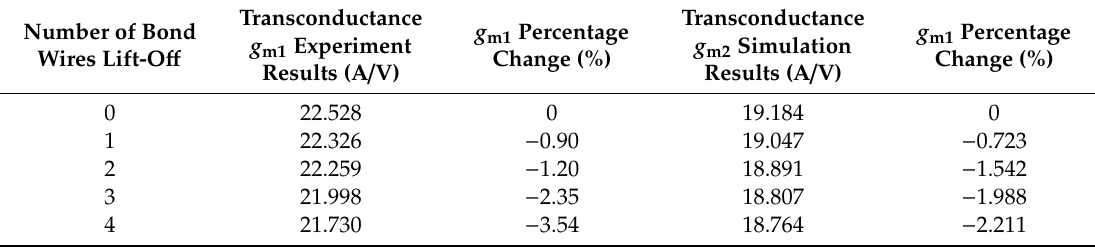
Table 11. Verification of simulation